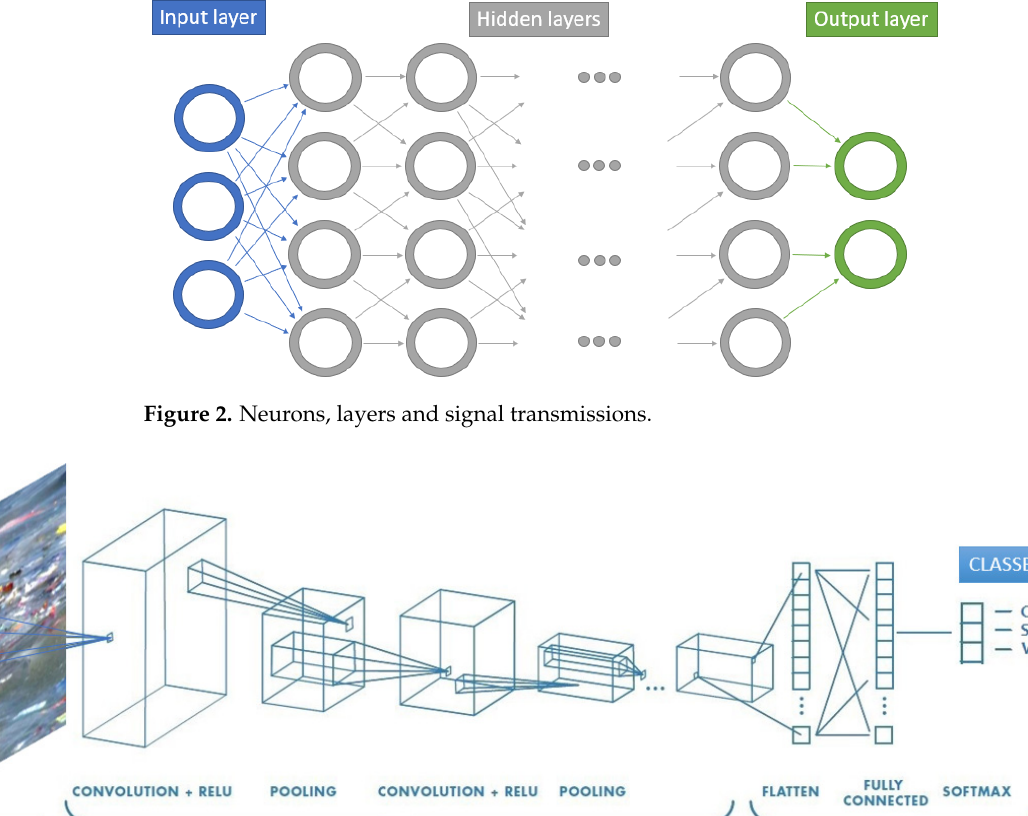
Figure 2. Neurons, layers and signal transmissions.